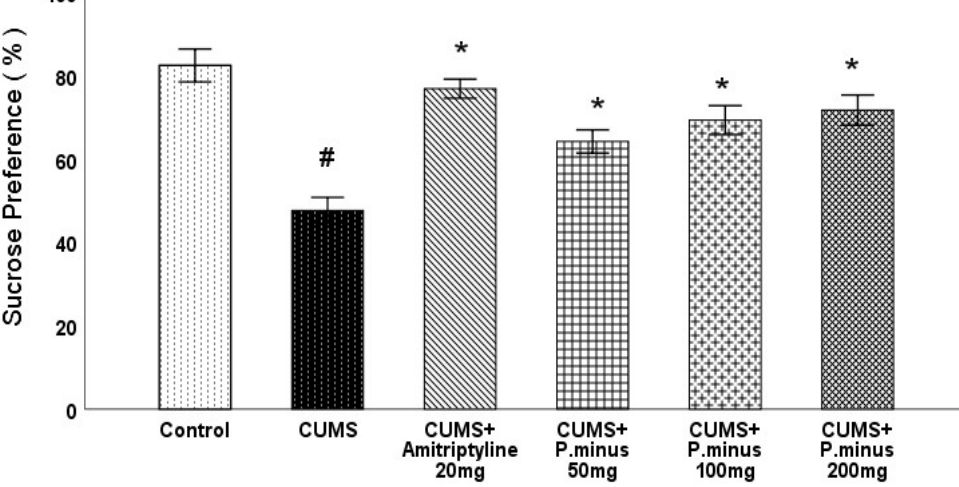
Figure 3. Effects of P. minus aqueous extract on sucrose preference test in CUMS induced depressive mice. # ( p < 0.05), vs. Control group; * ( p < 0.05), vs. CUMS group, ( n = 14) mice. # ( p < 0.05), vs. Control group; * ( p < 0.05), vs. CUMS group, ( n =